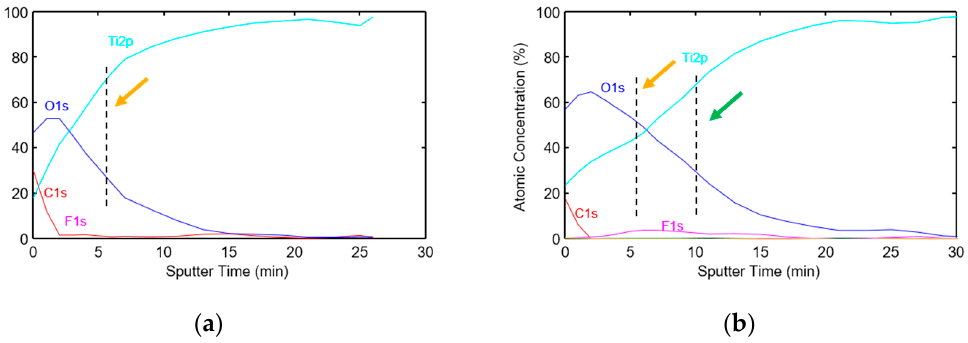
Figure 10. XPS depth profile of cTi ( a ) before and ( b ) after oxygen plasma treatment (orange and green arrows represent oxide layer thickness before and after the plasma treatment, respectively).